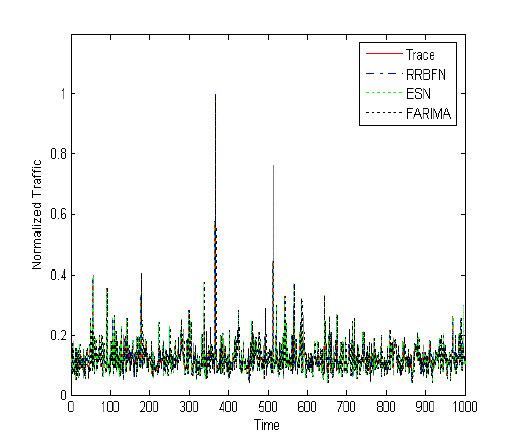
Fig. 8. 10-Step CCDF Plot (1-Second Interval)